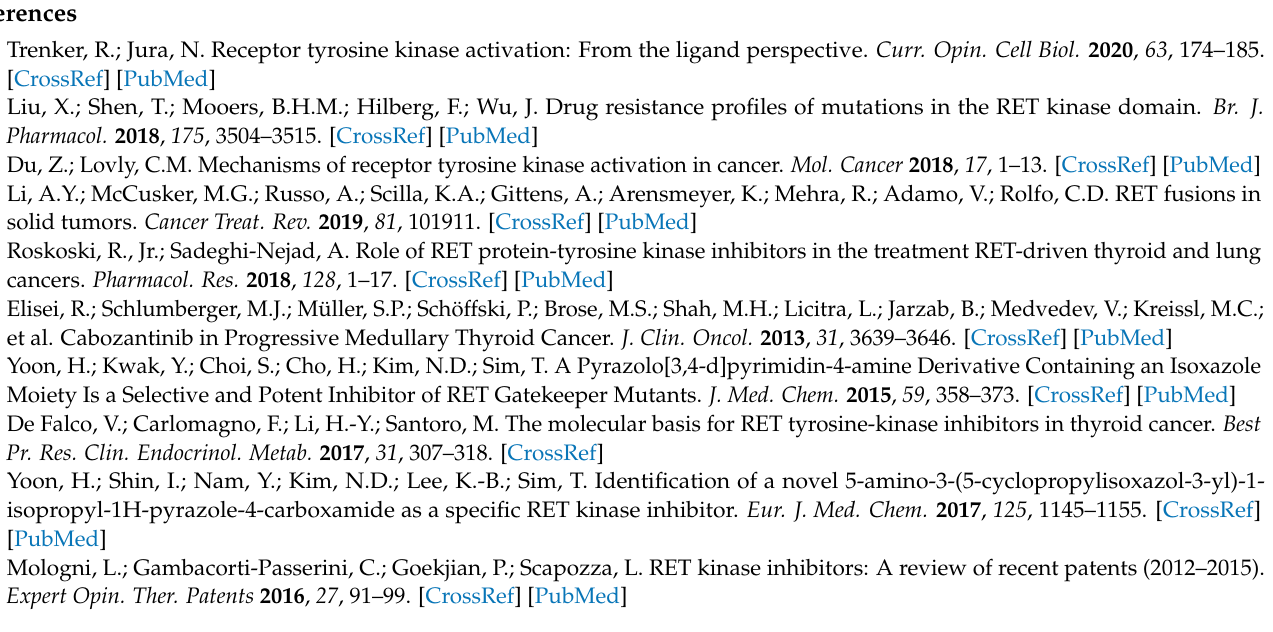
Figure S2: Superimposition of the initial (docked complex) and the final (100 ns) MD structure of the compound 25 inside in the binding site of RET